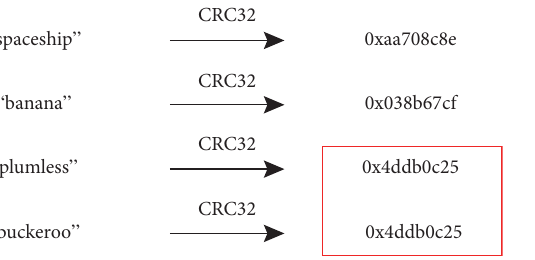
Figure 1: Conflict of CRC32